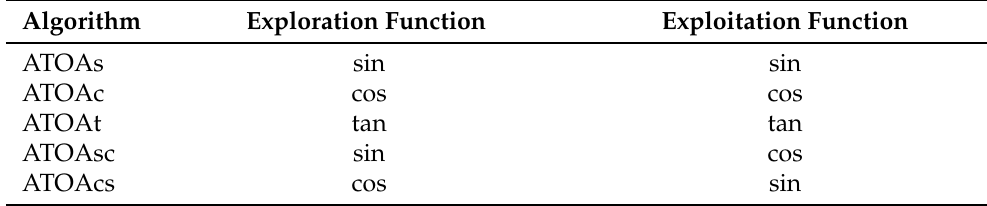
Table 1. List of developed algorithms with functions used in exploration and exploitation phases.